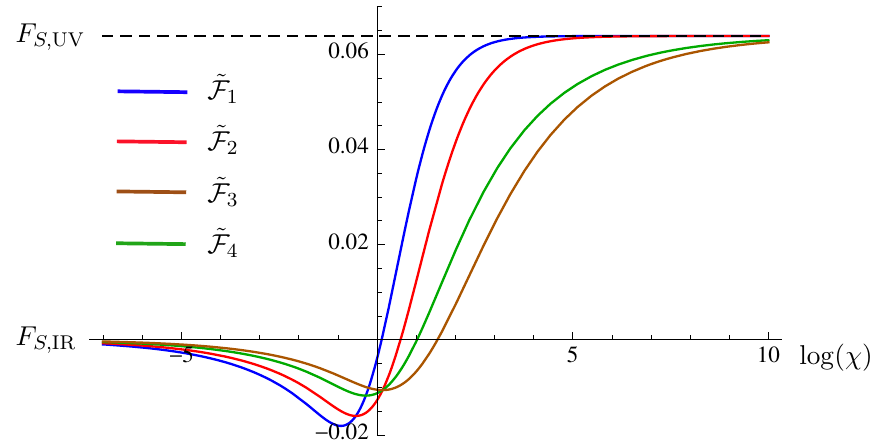
Figure 11. ~ F 1 ; 2 ; 3 ; 4 given in (6.24){(6.27) vs. log( (cid:31) ) with (cid:31) = ( (cid:11)m ) (cid:0) 2 for a theory of a free massive scalar on S 3 . The black dashed line indicates the value of F S; UV given in (6.5). For m ! 1 ( (cid:31) ! 0 at (cid:12)xed (cid:11) ) the theory becomes empty and we